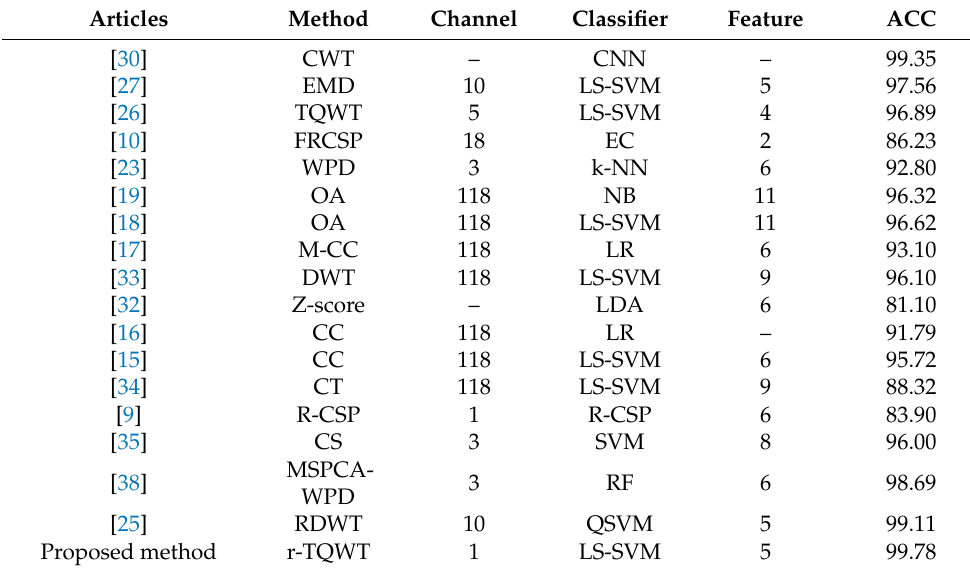
Table 7. Performance comparison with SOTA on the same